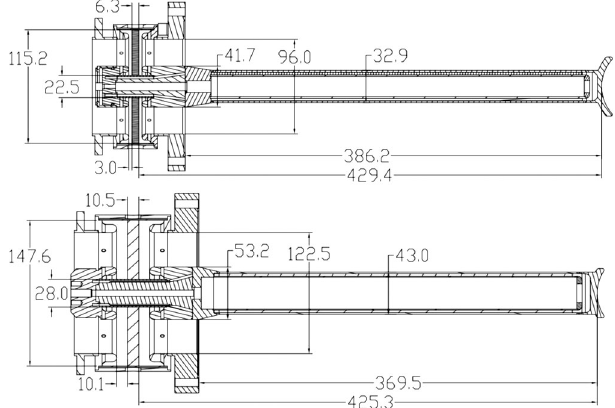
FIG. 5. EIC FPC window model (top) and optimized S11 result